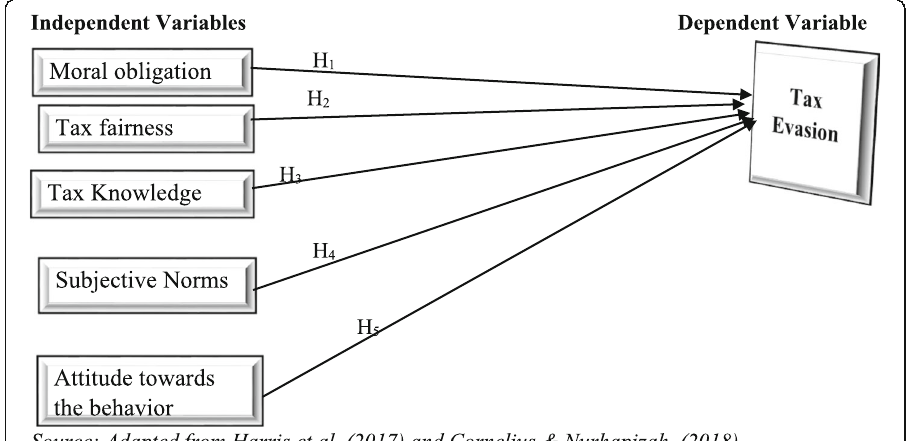
Fig. 1 Conceptual framework of the study. Adapted from Alleyne and Harris (2017) and Rantelangi